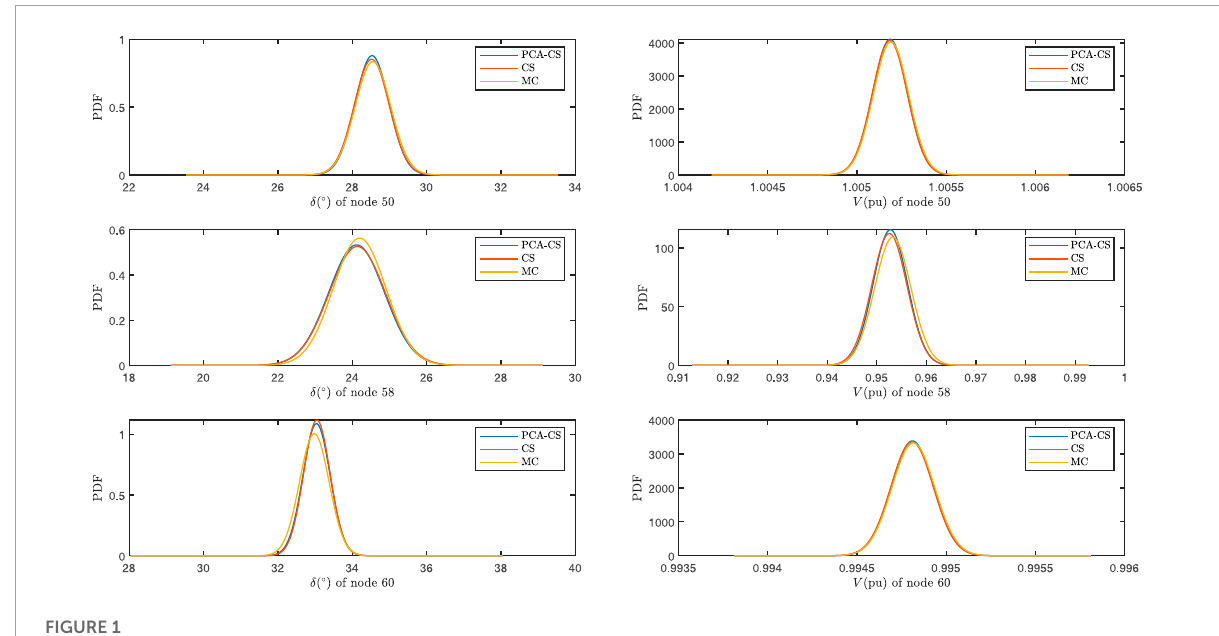
FIGURE 1 Probability density function (PDF) of node voltage amplitude V and phase angle δ